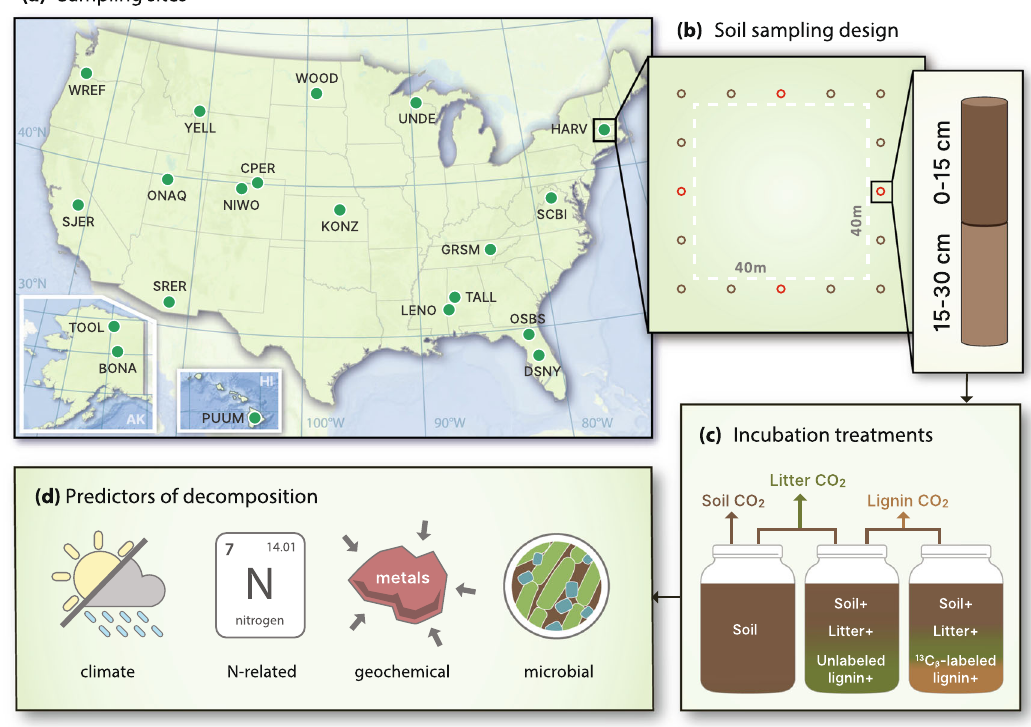
Fig. 1 | Sampling sites and experimental design of this study. a The 20 NEON sampling sites; b soil sampling points around a 40×40-m plot at each site; c experimental design to partition sources of C decomposition; and d biogeochemical predictors, which included climate, N-related, geochemical,and microbial variables (Supplementary Table 2). For lab incubation, four mineral soils at 0 – 15 and 15 – 30cm (e.g., points in red, b ) were incubated with three substrate